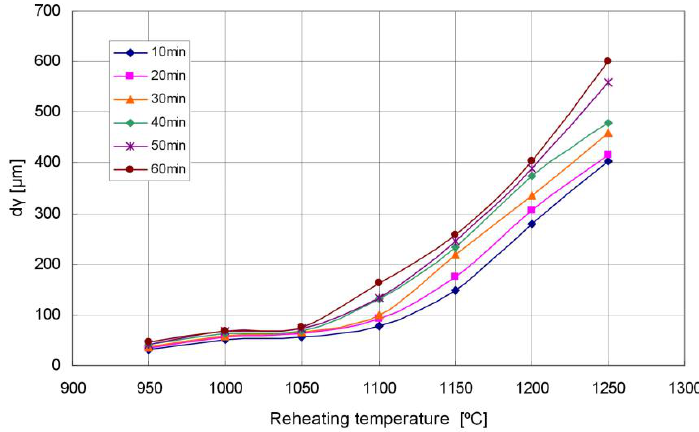
Figure 11. Austenite grain size versus temperature (reproduced from [21], with permission from the authors, 2009). authors,